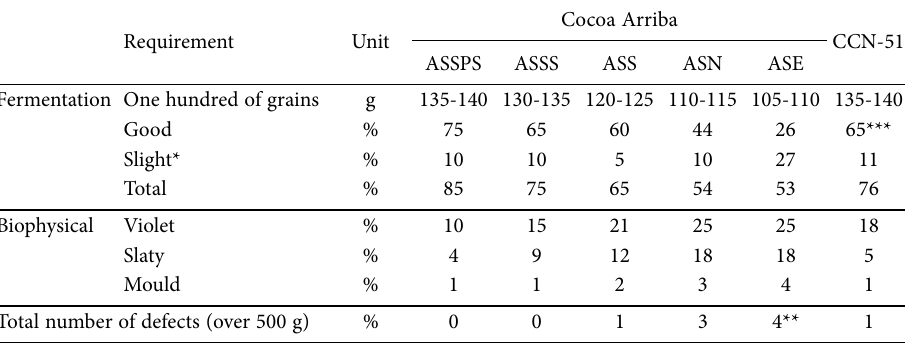
Table 1. Standards of Cacao Arriba PDO and